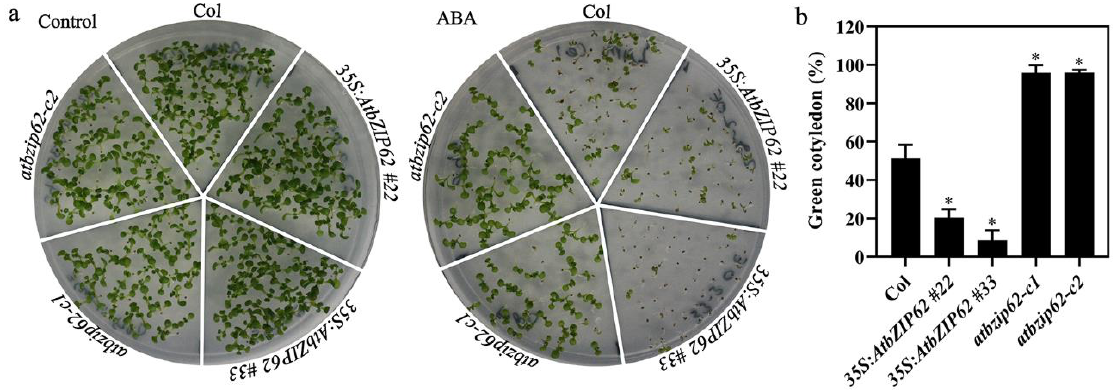
Figure 5. Effects of ABA on cotyledon greening of Col wild type, the 35S:AtbZIP62 transgenic plants and the atbzip62 mutants. ( a ) Cotyledon greening of Col wild type, the 35S:AtbZIP62 transgenic plants, and the atbzip62 mutants in the presence and absence of ABA. Sterilized seeds were sown on 1/2 MS plates in the presence or absence of 1 μM ABA. After being kept at 4 °C in darkness for 2 days, the plates were transferred to a growth room. Pictures were taken 8 days after the transfer. ( b ) Quantitative assays of cotyledon greening of the Col wild type, the 35S:AtbZIP62 transgenic plants, and the atbzip62 mutants in the presence of 1 µ M ABA. Seedlings with green cotyledons were counted 8 days after the transfer, and the percentage of green seedlings was calculated. Data represent means ± SD of three replicates. * significantly different from that of the Col wild type (student’s t -test, p <